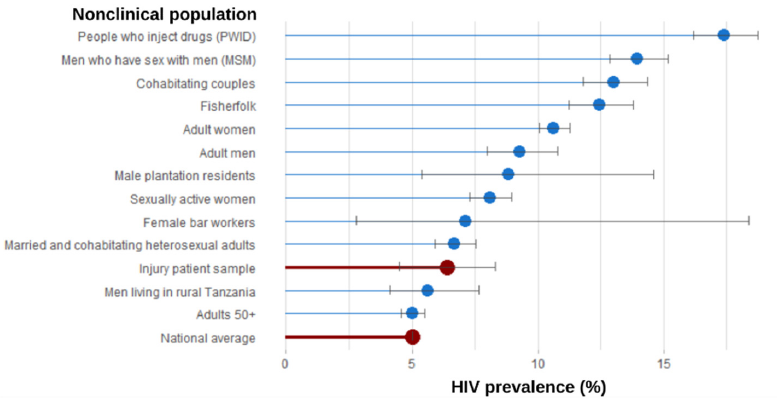
Figure 3. Comparing HIV prevalence estimates of nonclinical population groups identified via sys- tematic review with the ED injury patient sample and national average.